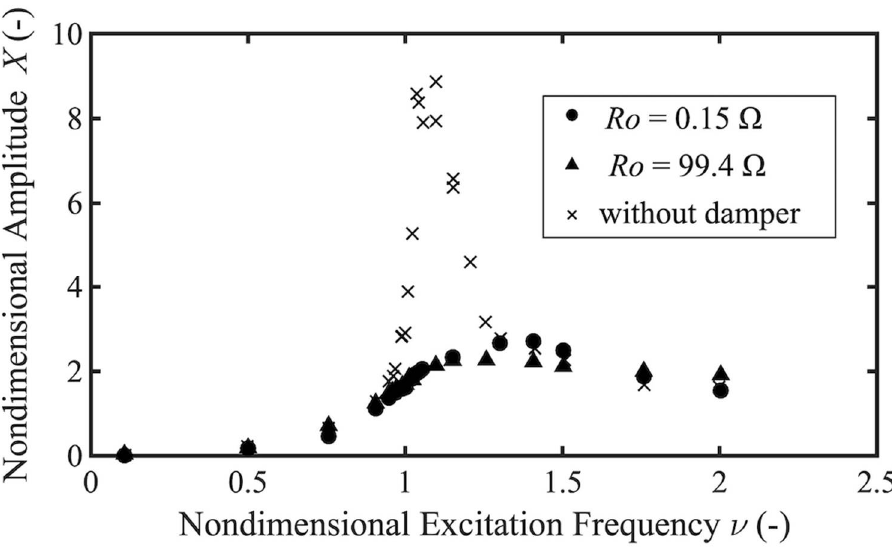
Figure 6. Frequency response plots of the vibration amplitude of the permanent magnet obtained by experiments with the parallel-type shunt damper.